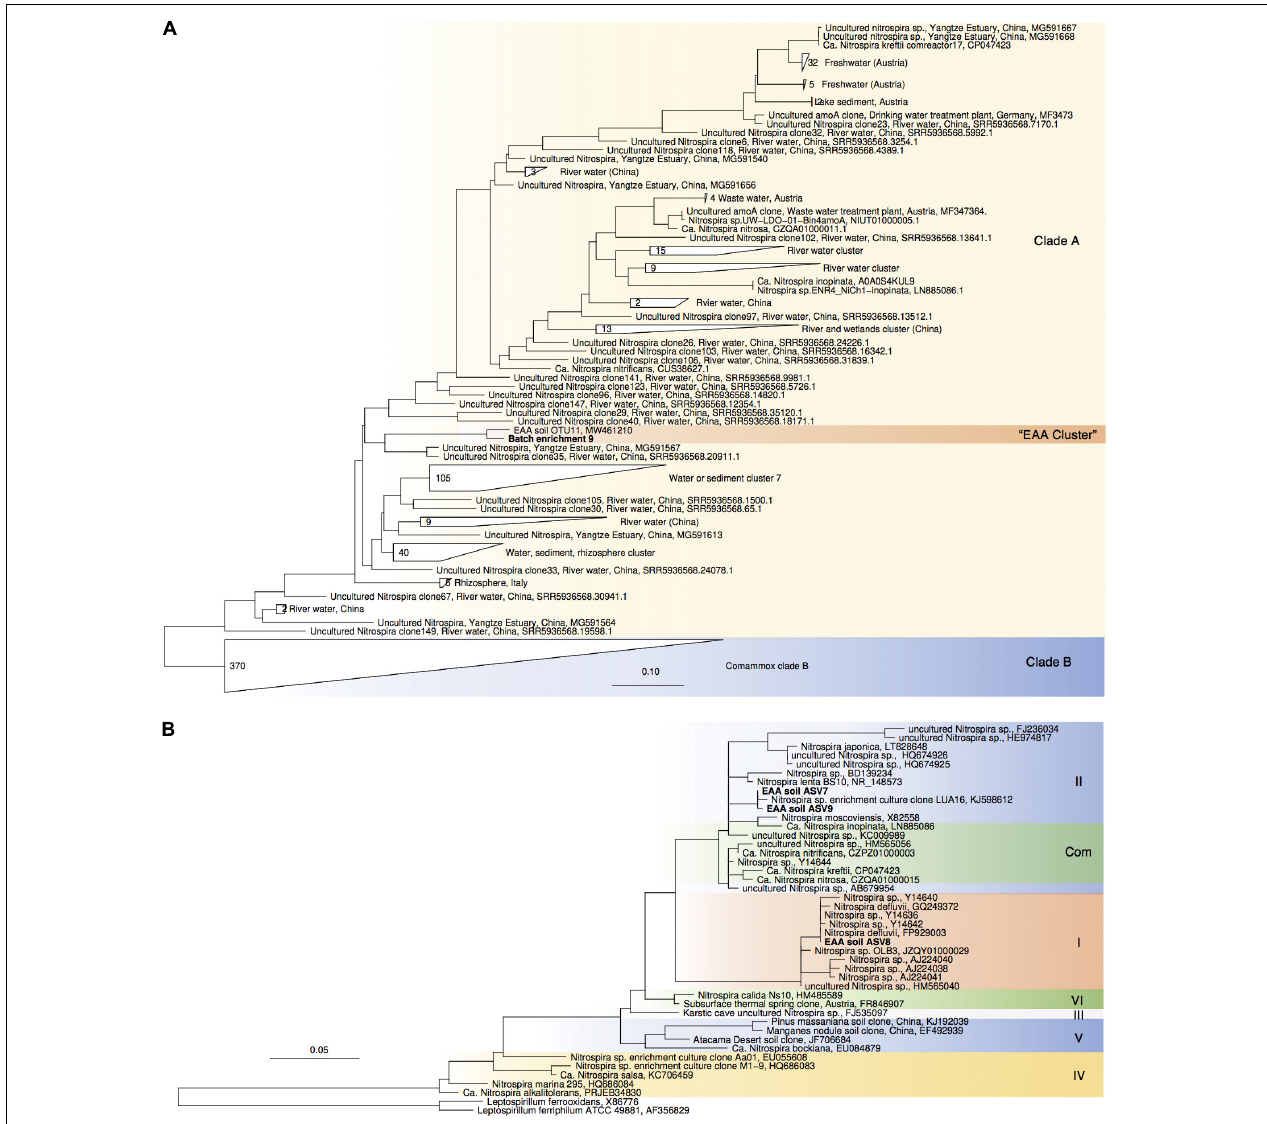
FIGURE 4 | Maximum-likelihood phylogenetic trees of comammox amoA gene sequences (A) and Nitrospira sp.-affiliated 16S rRNA gene sequences (B) . Sequences obtained from batch enrichment culture 9 are highlighted in bold. Comammox clade B sequences, and Leptospirillum sp. sequences were used as outgroups,